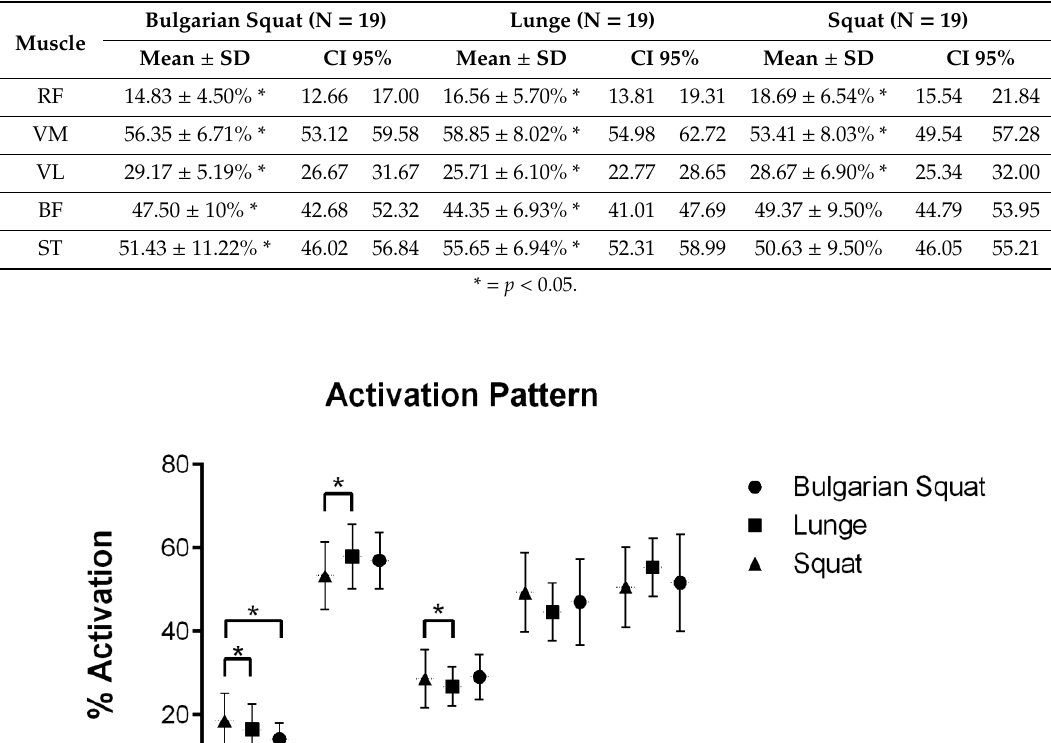
Table 1. Intra-muscular group activation (mean ± standard deviation) in percentage.